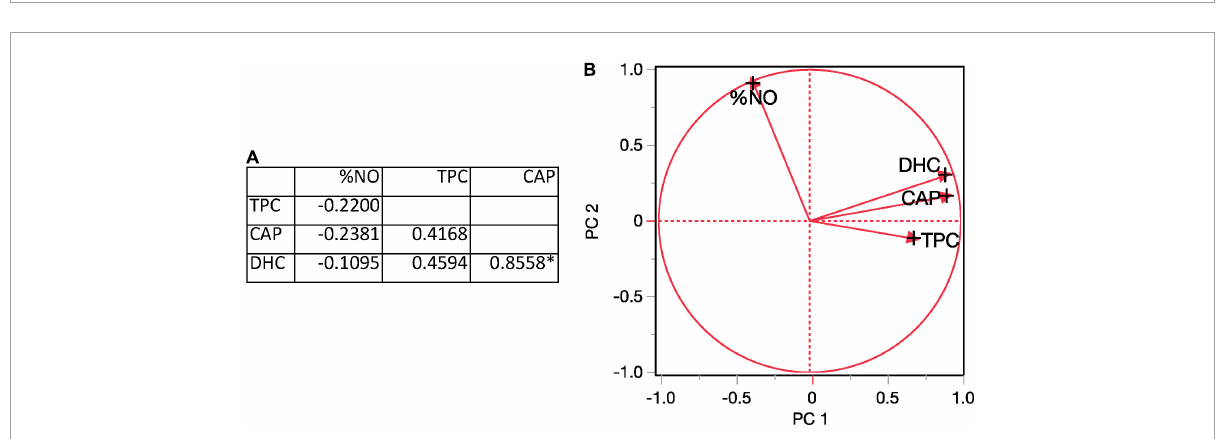
FIGURE5 Correlation analysis of the extraction variables: (A) correlation matrix for the total phenolic compound (TPC), CAP, DHC, and %NO production, and (B) factor loading plot of principal components of the extraction variables.